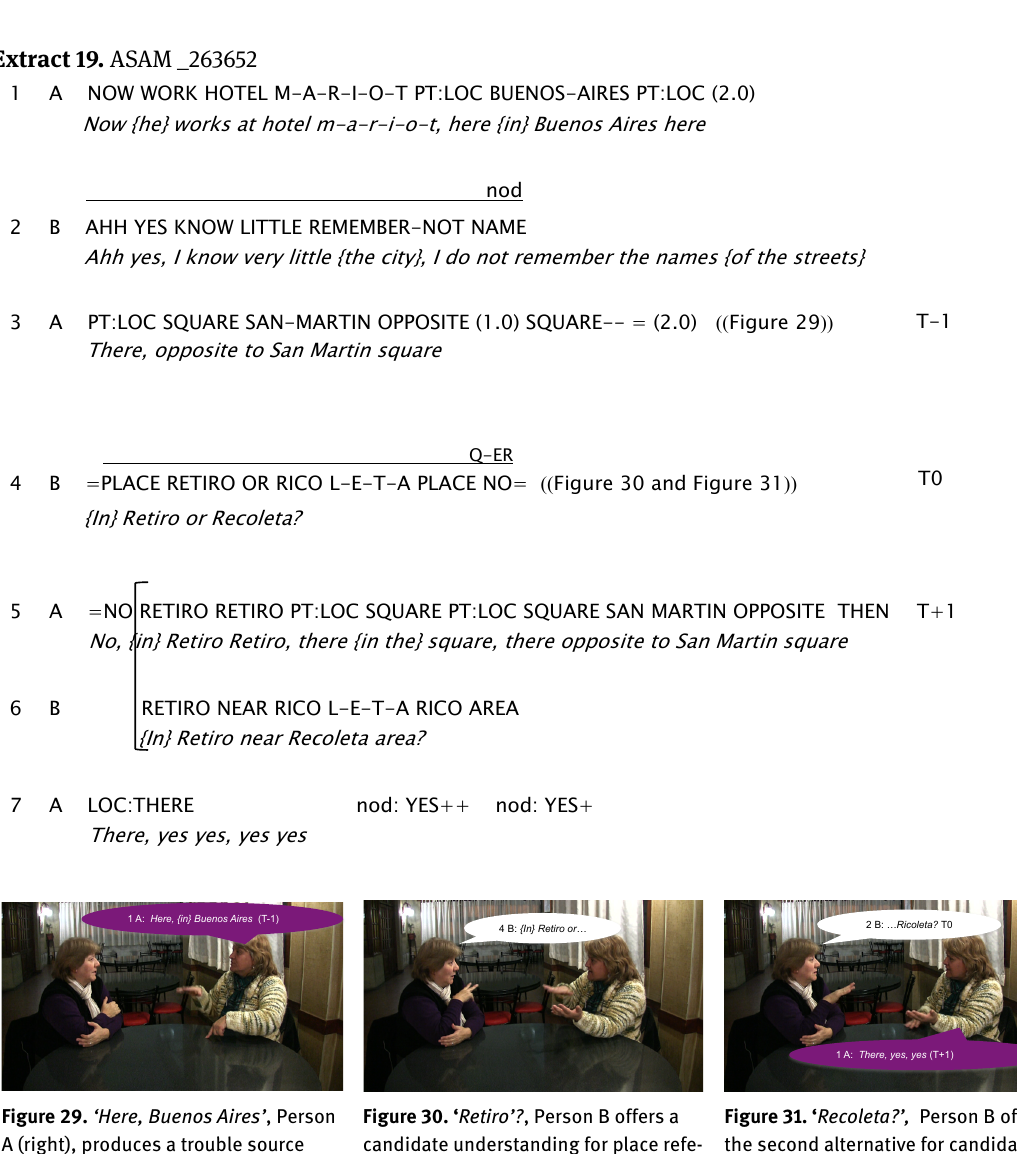
Figure 30. ‘ Retiro’? , Person B offers a candidate understanding for place refe- rence combined with eyebrows raised as question marker (line 4).